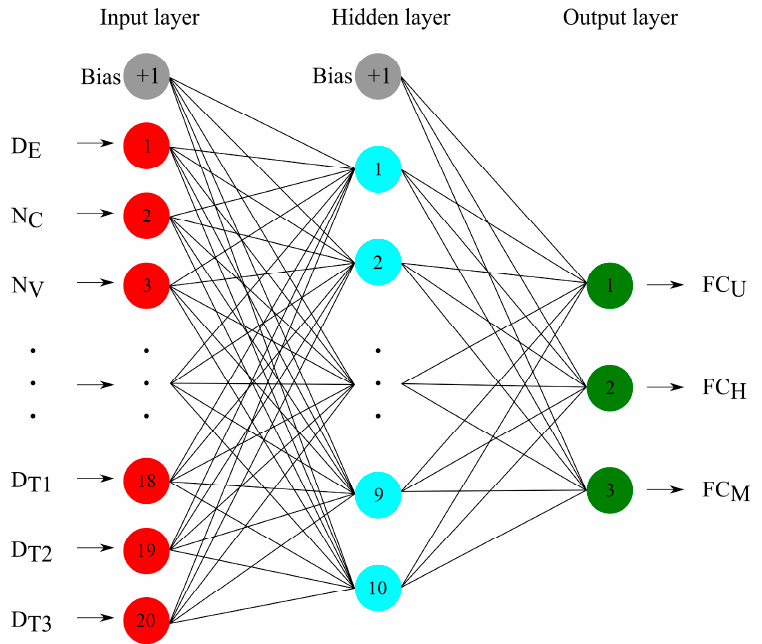
the manner of the synaptic pathways between the neurons of the adjacent layers.